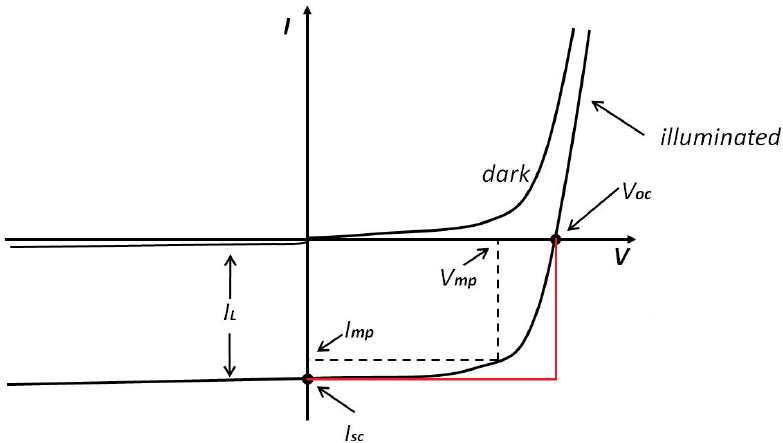
Fig. 6. – Example current-voltage curve of a real solar cell. A solar cell JV curve and its